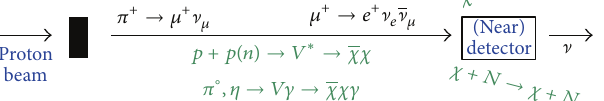
Proton beam Figure 14: (Color online) The concept of the dark matter beam in MiniBooNE [116]. The dominant production mode of dark matter particles is decays of the mediator particles created by decays of neutral mesons. The dark matter particles can be also made through the direct collisions of protons on the beam